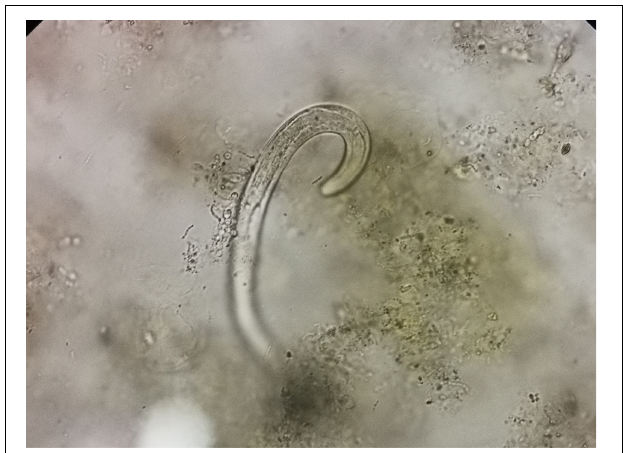
FIGURE 2 | Larvae of S. stercoralis were identified in gastric fluid (unstained, ×